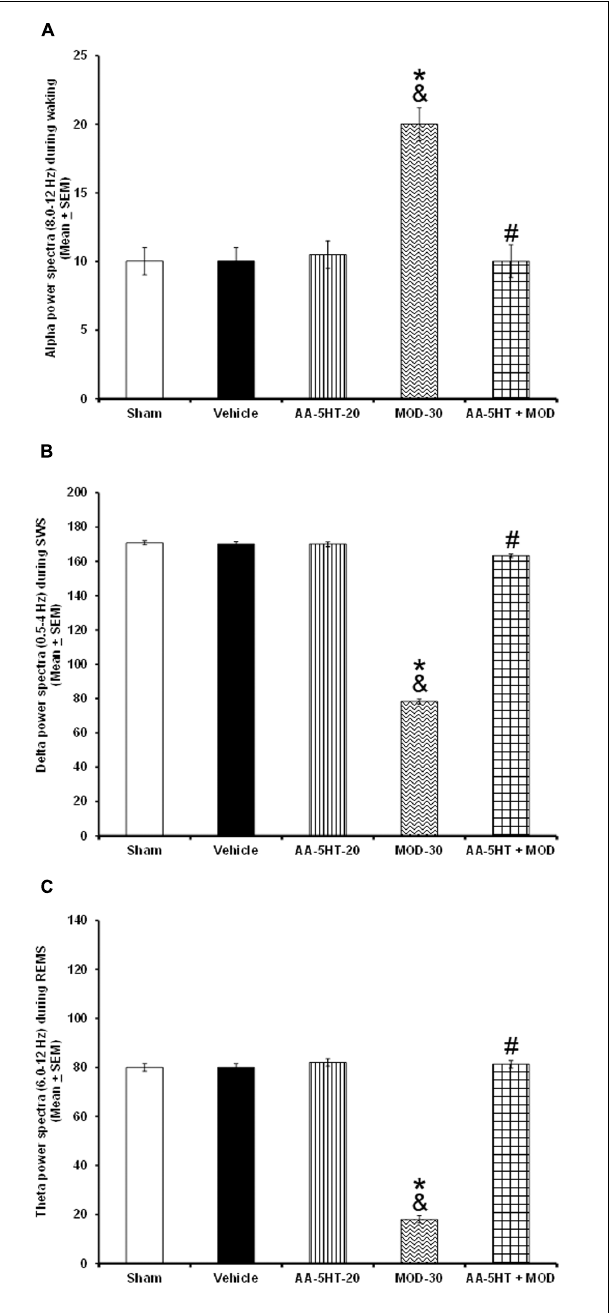
FIGURE 7 | Effects on EEG power spectra (alpha [for W: α = 8–12 Hz], delta [for SWS: (cid:49) = 0.5-4.0 Hz], or theta [for REMS: (cid:50) = 6.0–12.0 Hz]) after experimental trials: Sham, vehicle, AA-5-HT (20 mg/Kg; i.p.), modafinil (MOD; 30 mg/Kg; i.p.) or AA-5-HT (20 mg/Kg; i.p.) and 15 min MOD (30 mg/Kg; i.p.) at the beginning of the lights-on period. AA-5-HT caused no statistical effects in power spectra. However, injection of MOD (30 mg/Kg; i.p.) increased alpha and decrease delta and theta power spectra. Moreover, injection of AA-5-HT before administration of MOD was able to block the enhancement in in alpha, delta and theta power spectra ( A–C , respectively. Mean ± SEM ∗ vs. Sham/Vehicle, P < 0.05; & vs. AA-5-HT-20, P < 0.05; # vs. MOD-30, P < 0.05). Abbreviations: Modafinil 30 mg/Kg, i.p. (MOD-30), AA-5-HT-20 mg/Kg